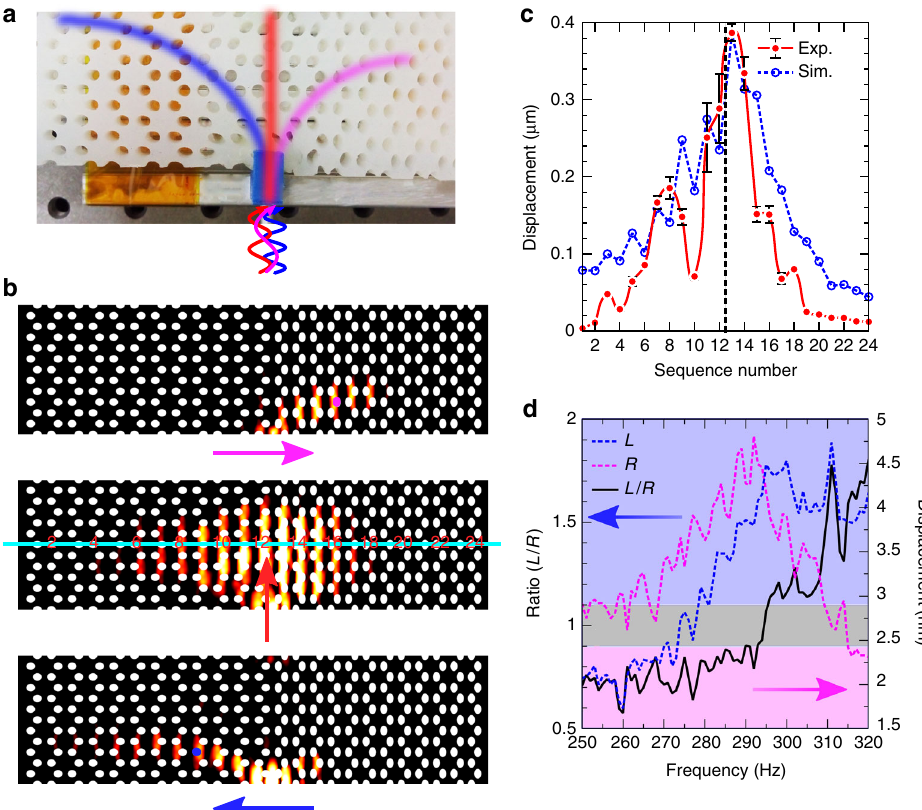
Fig. 4 Experimental observation of topological interface state and demonstration of elastic wave splitter. a Experimental setup of a Eco fl ex slab consisting with two elastic metamaterials, (0.6, 5.56%|0.68, − 8.89%). Magenta, red, and blue lines schematically indicate elastic waves propagation directions as a function of input frequency. b Numerical simulations of vertical displacement fi elds with different transverse wave propagations at three input frequencies: 261, 274, and 286Hz, from top to bottom. c Experimental observation of topological interface state at 274 Hz corresponding to the second panel in b , by measuring the displacement of the 24 holes marked by cyan line. Values of the measured displacements represent the mean of n tests ( n = 5, error bars are de fi ned as s.d.). Simulation results are shown in blue dashed line. Sequence numbers marked in red indicate the hole numbers. The black dashed line indicates the position of interface between two metamaterials. d Experimentally measured displacement on the right side at the magenta hole is presented by the magenta dashed curve. Experimentally measured displacement on the left side at the blue hole is presented by the blue dashed curve. The displacement ratio of the left side over the right side, L / R is presented as a function of input frequency (black solid curve). Magenta domain indicates the right propagation mode, while the blue domain reveals the left propagation mode. Gray region is the intermediate mode de fi ned in main